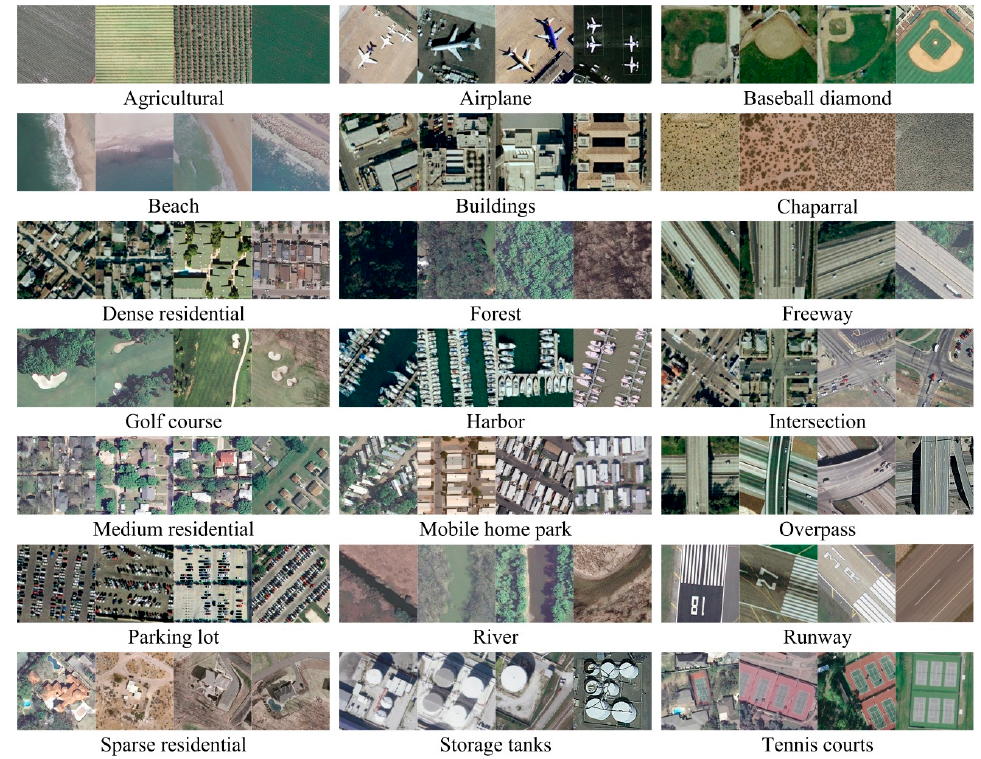
Figure 4. Sample images of the adopted UCM dataset.